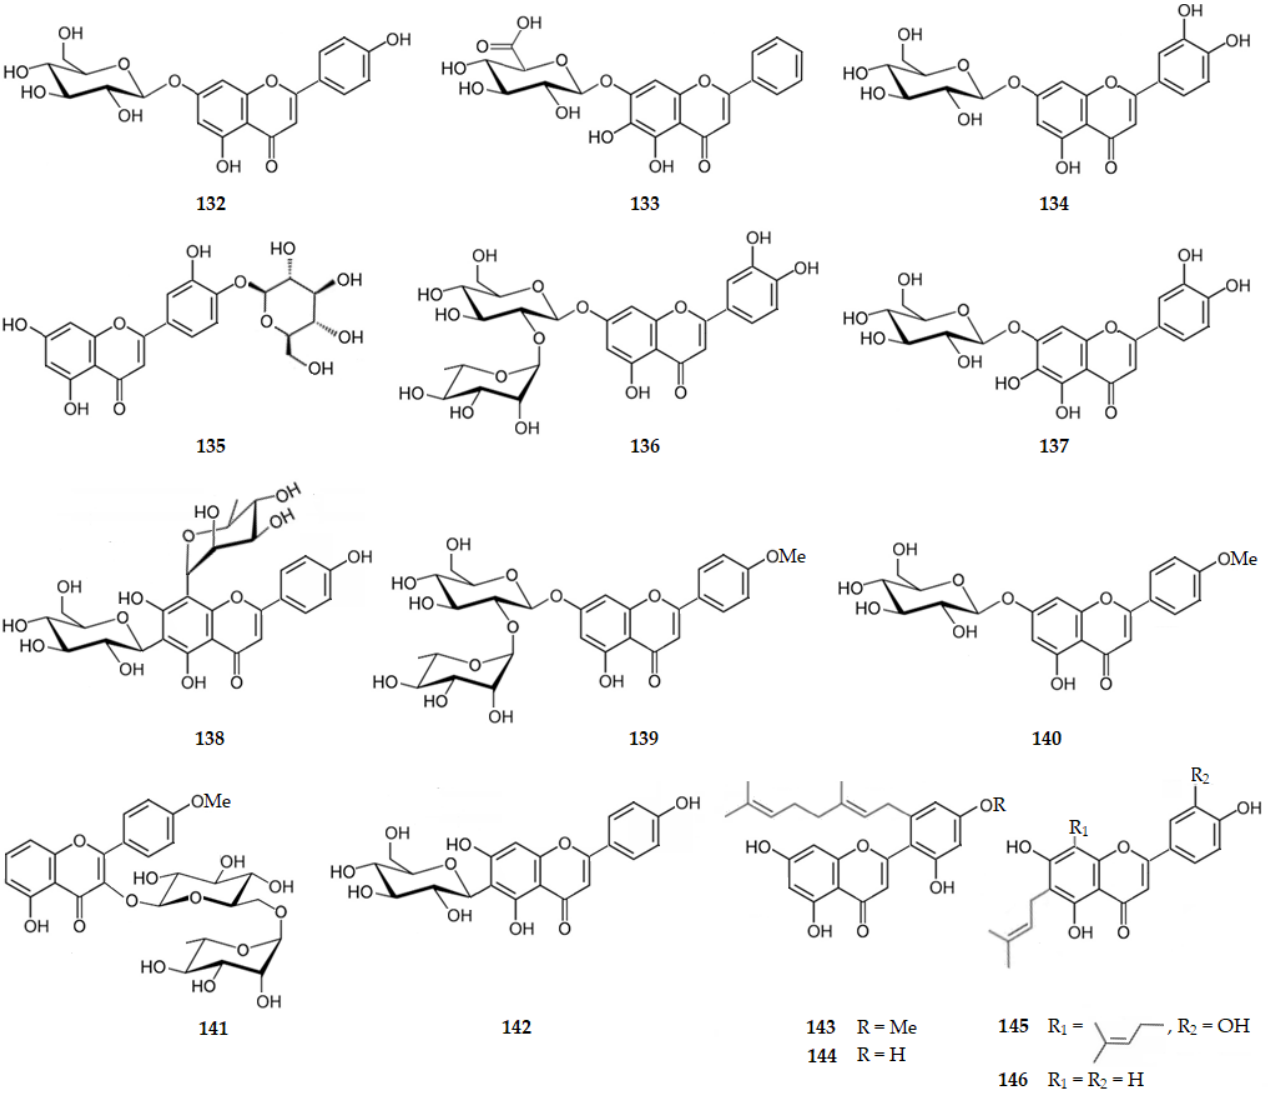
Figure 14. Structure of flavones that inhibit AChE and of the inactive flavones 136 , 139 and 140 .